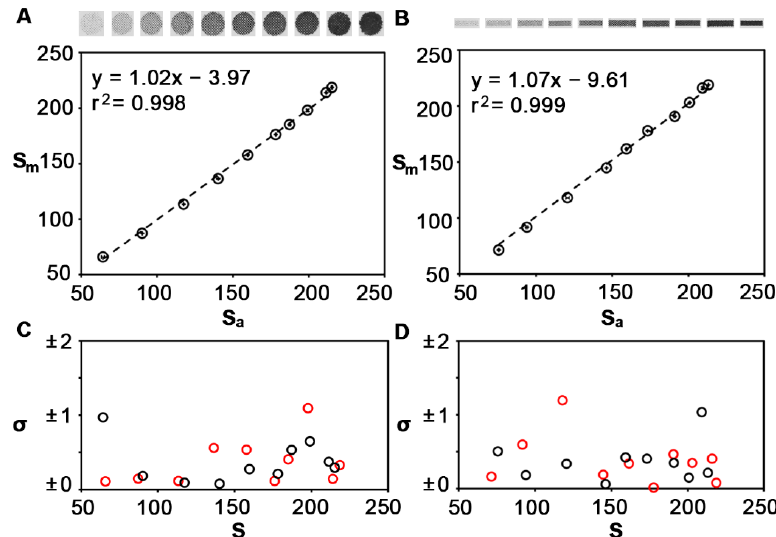
Figure 3. Comparison of larger signals obtained using the manual method (Sm) and the automated method (Sa) for quantifying the pixel intensity. Correlation plots when the spots are shaped like a large circle ( A ), or a large rectangle ( B ), circles are the mean and error bars are the standard deviation ( n = 3). Standard deviation ( σ ) associated with colorimetric signals S obtained with the proposed software (black) or with the manual method (red) ( C , D ).